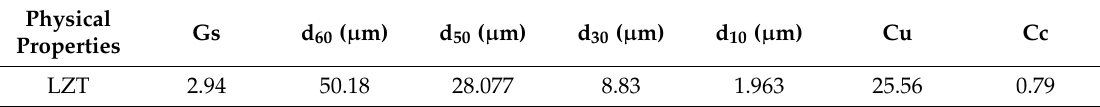
Table 3. Physical properties of lead–zinc tailing (LZT).